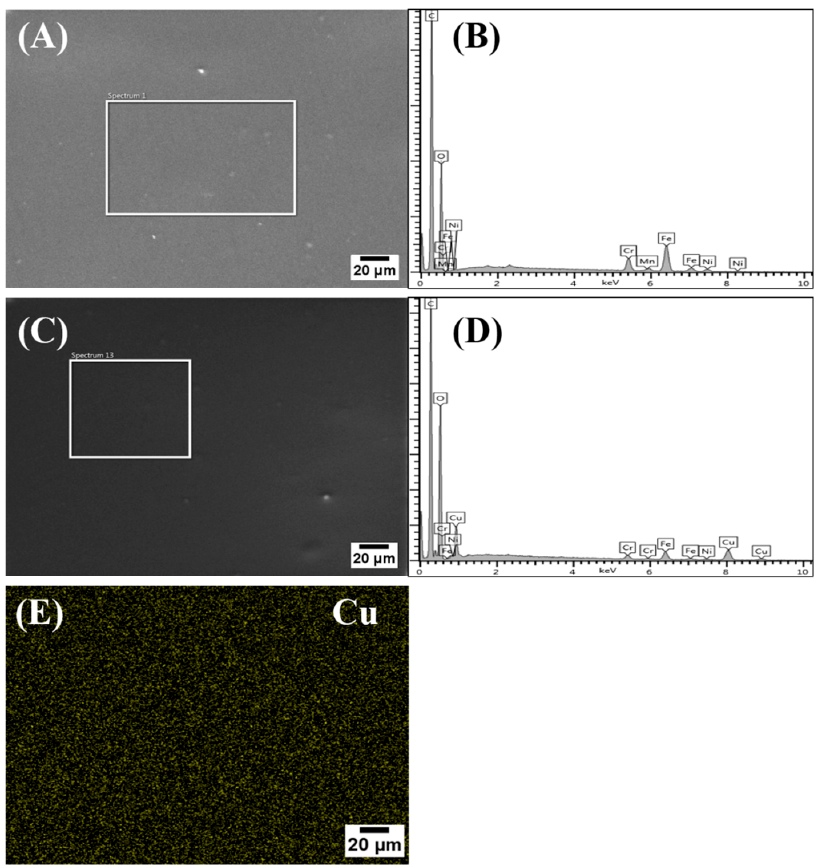
Figure 2. EDX spectra of coatings: ( A ) SEM image of CS, ( B ) EDX pattern of CS, ( C ) SEM image of Cu(II)–CS4, ( D ) EDX pattern of Cu(II)–CS4, and ( E ) Cu mapping on Cu(II)–CS4 coating.